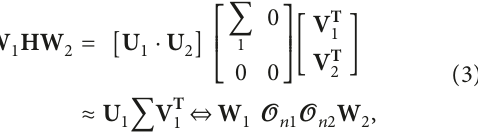
2.2m. (b) Depth d (cid:31) (cid:31) − −